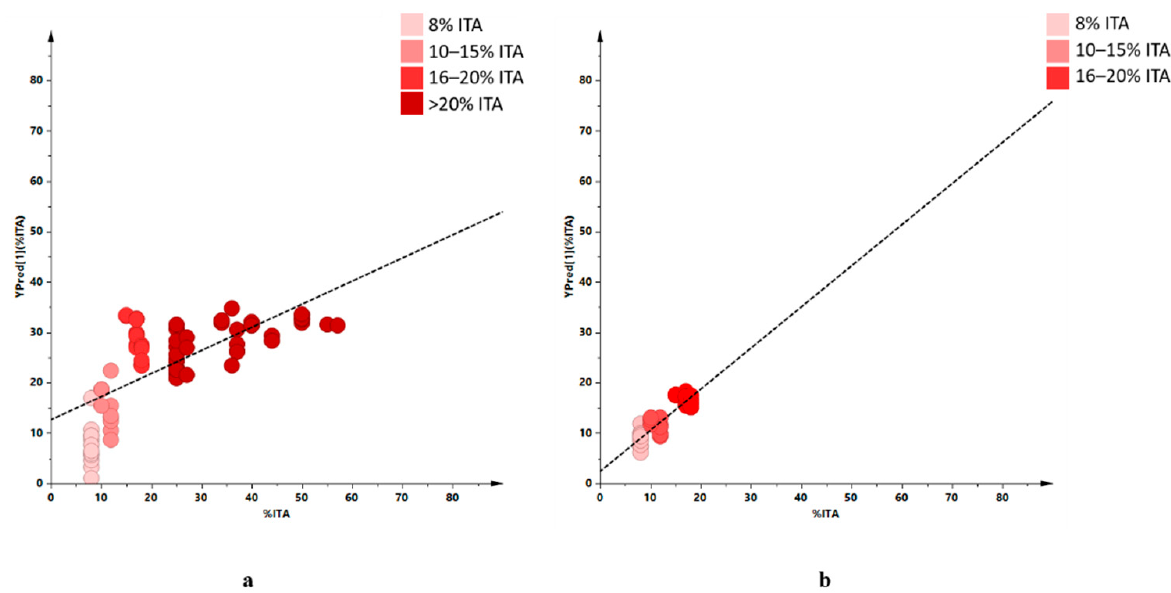
Figure 3. ( a ) The partial least squares regression (PLSR) model for organic European community and non-community extra virgin olive oil (EVOO) blend samples as a function of the percentage of Italian oil calculated for each blend sample. One component, R 2 X (cum) = 0.662, R 2 Y (cum) = 0.816 and Q 2 (cum) = 0.809, goodness of fit R 2 = 0.816. Root mean square error of cross-validation (RMSECV)(Y) = 1.7766. ( b ) The PLSR in Figure 3a limited to the specific range 8–20% ITA. Table 2. Coefficient of determination R 2 for each country within the organic EU community and non-community EVOO blends.